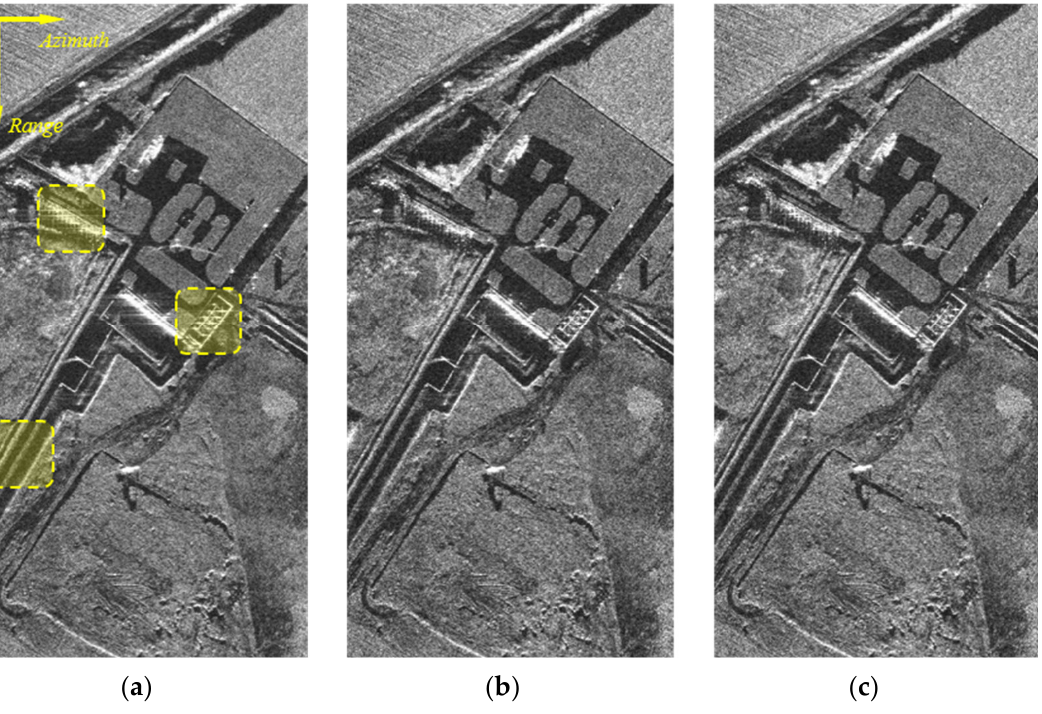
Figure 13. Real data experiment results of the high-resolution UAV-borne Ka-band CF-SAR. ( a ) Result processed by RDA. ( b ) Result processed by FFBPA. ( c ) Result processed by the algorithm proposed in [8].